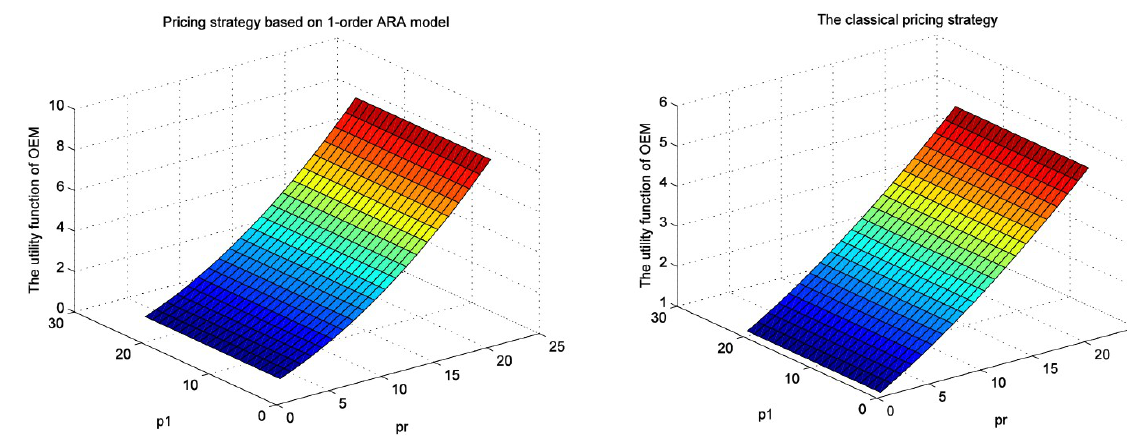
Figure 1. The OEM’s pricing strategy based on 1-order ARA model